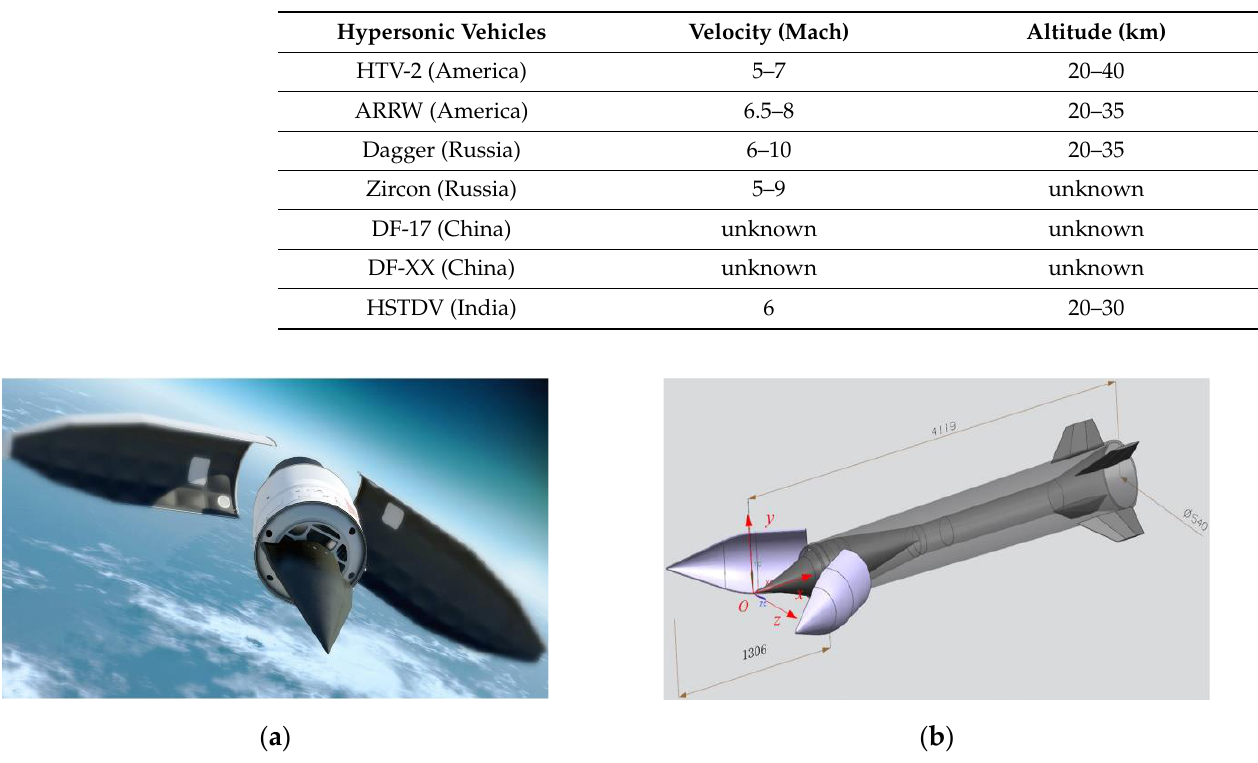
Figure 1. Shroud separation of hypersonic vehicles: ( a ) shroud separation of hypersonic technology vehicle #2 (HTV-2) [4]; ( b ) shroud separation of hypersonic air-breathing vehicle (HAV) [5]. Figure adapted with permission from Wang et al. (2017). Copyright © 2017 American Institute of Aeronautics and Astronautics (AIAA).